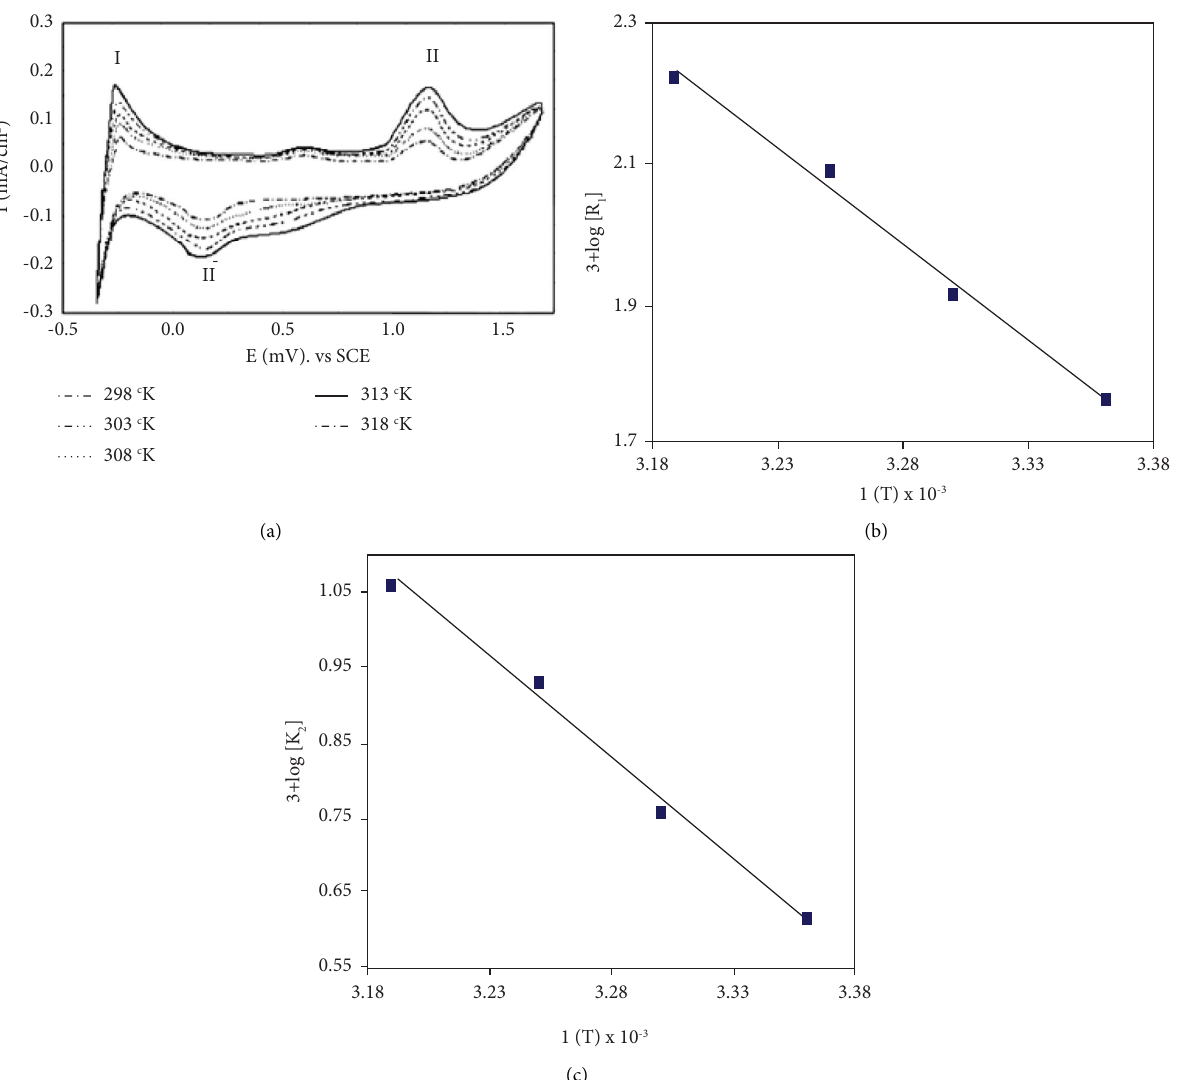
Figure 6: (a) Efect of temperature on the cyclic voltammograms. (b) Arrhenius plot. (c) Eyring plot of the anodic oxidative electro-